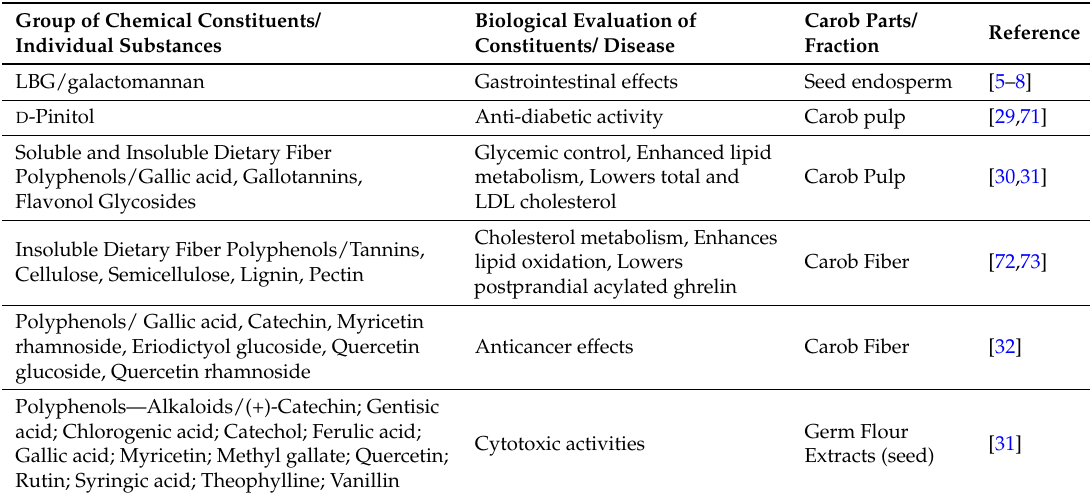
Table 2. The chemical components of carob and their biological evaluation Group of Chemical Constituents/ Individual